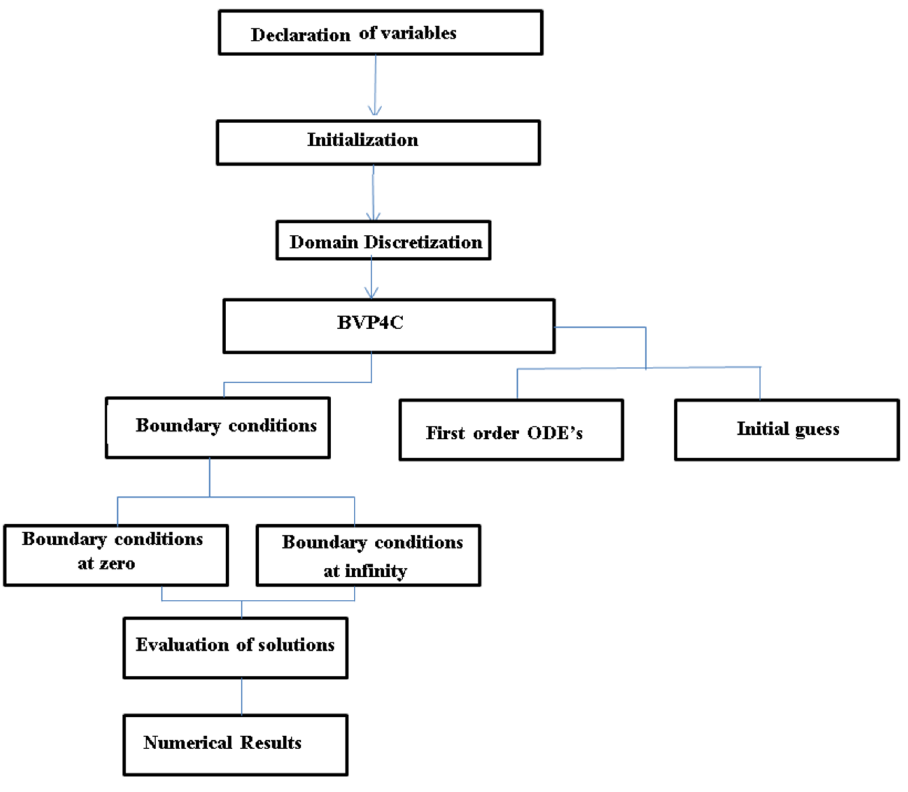
Figure 2. Flow chart of numerical